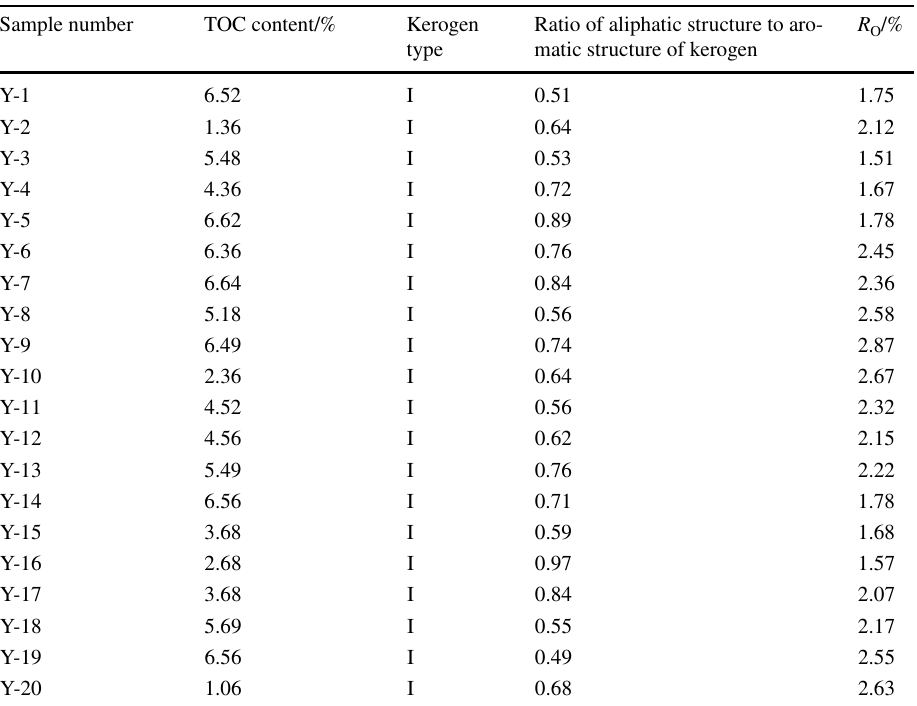
Table 2 Organic geochemical parameters of samples